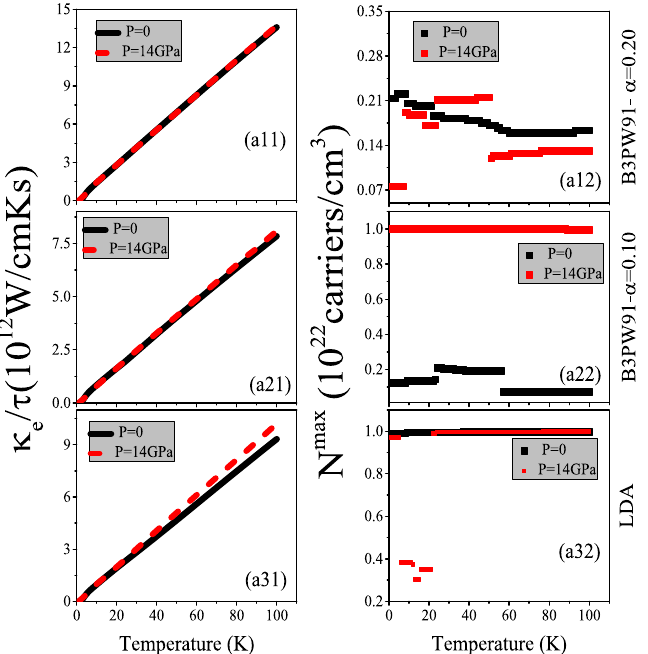
Figure 5. ( ai1 ) Maximum values of spin up electronic thermal conductivity per relaxation time ( τ ), i.e., κ max e /τ , of electron/hole doped CeIn 3 versus temperature for T ≤ 100 K calculated using B3PW91 with α = 0.20, 0.10 and LDA for P = 0 and 14 GPa pressures. Doping levels related to κ max e /τ are displayed in the ( ai2 ) panels. In the AFM phase, spin down results are the same as spin up results.